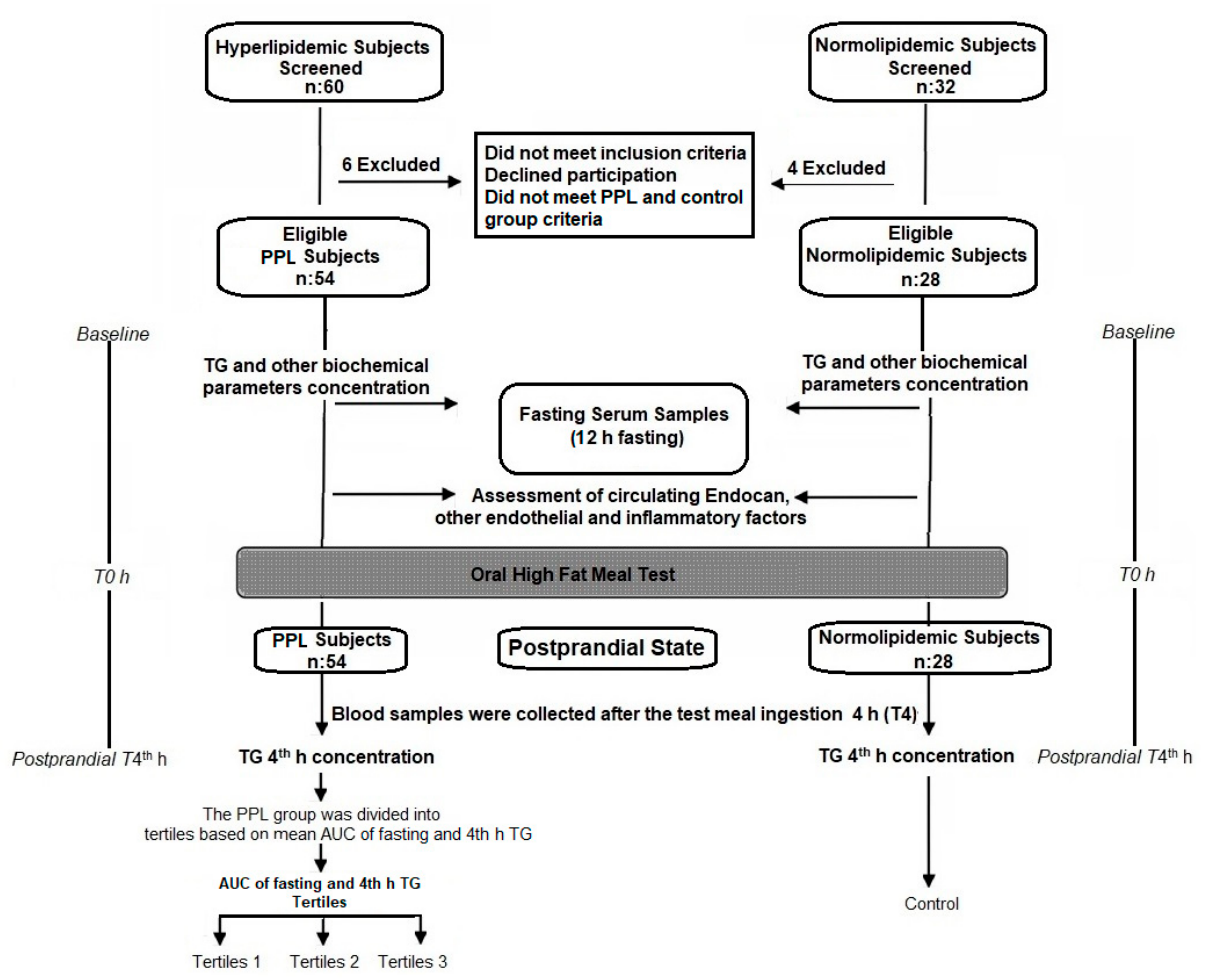
Figure 1. Flowchart showing control and PPL groups included in the study.